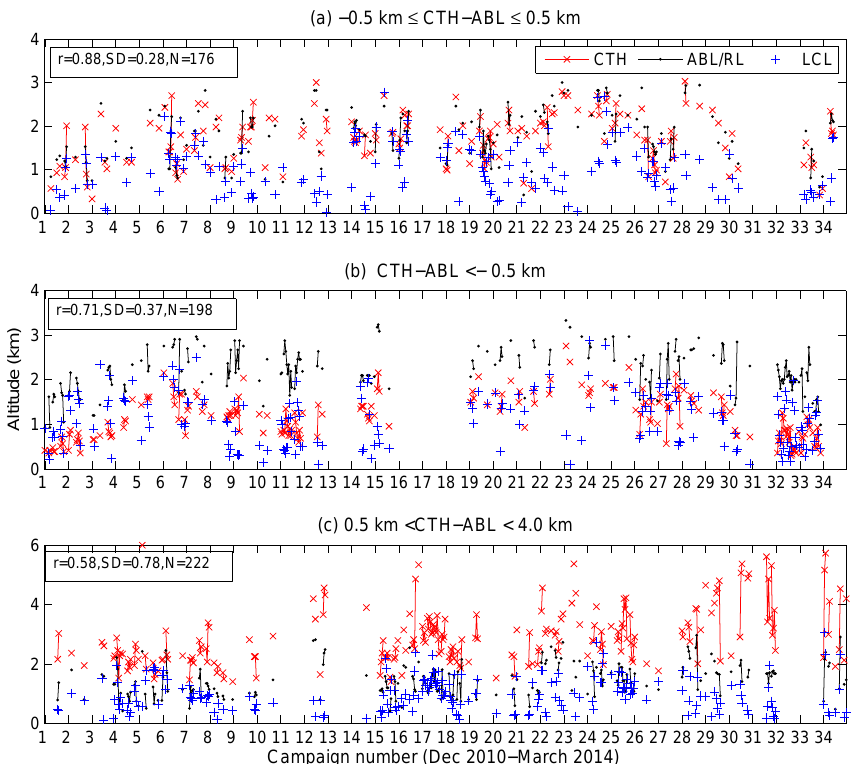
Figure 13. Time series of the CTH, the ABL CR top, and the LCL observed for the cases (a) − 0.5km ≤ CTH–ABL ≤ 0.5km, (b) CTH– ABL< − 0.5km, and (c)